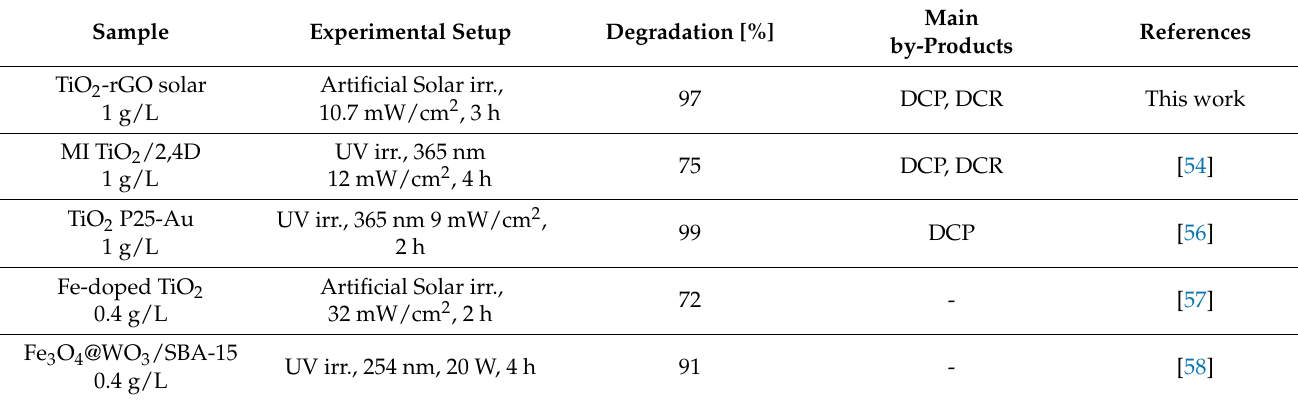
Table 5. Comparison amongst some recent literature data on photocatalytic 2,4-D